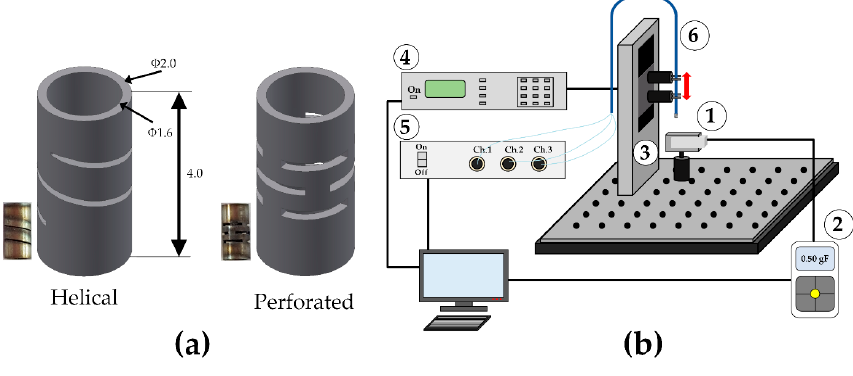
Figure 1. ( a ) Helical and perforated pattern structure for force sensor tip with same dimensions (all dimensions are millimeter) ( b ) Schematic of the force measurement setup (1) load cell (2) force gauge (3) linear stage (4) motion controller (5) interrogator (6) FBG force